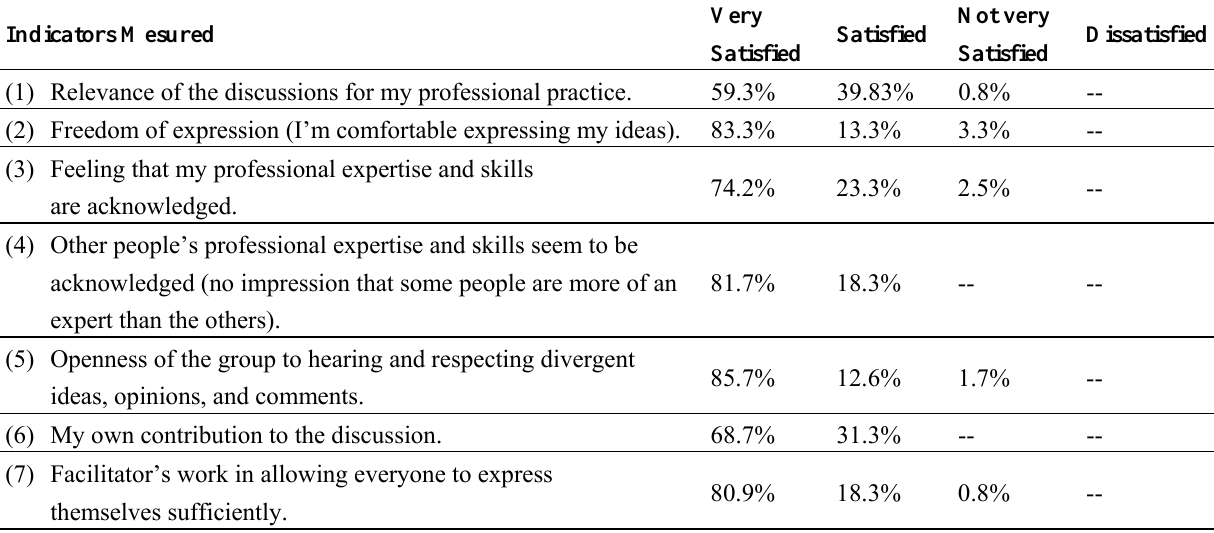
Table 1. Practitioners’ Satisfaction with the Participation Meetings for Each of the Following